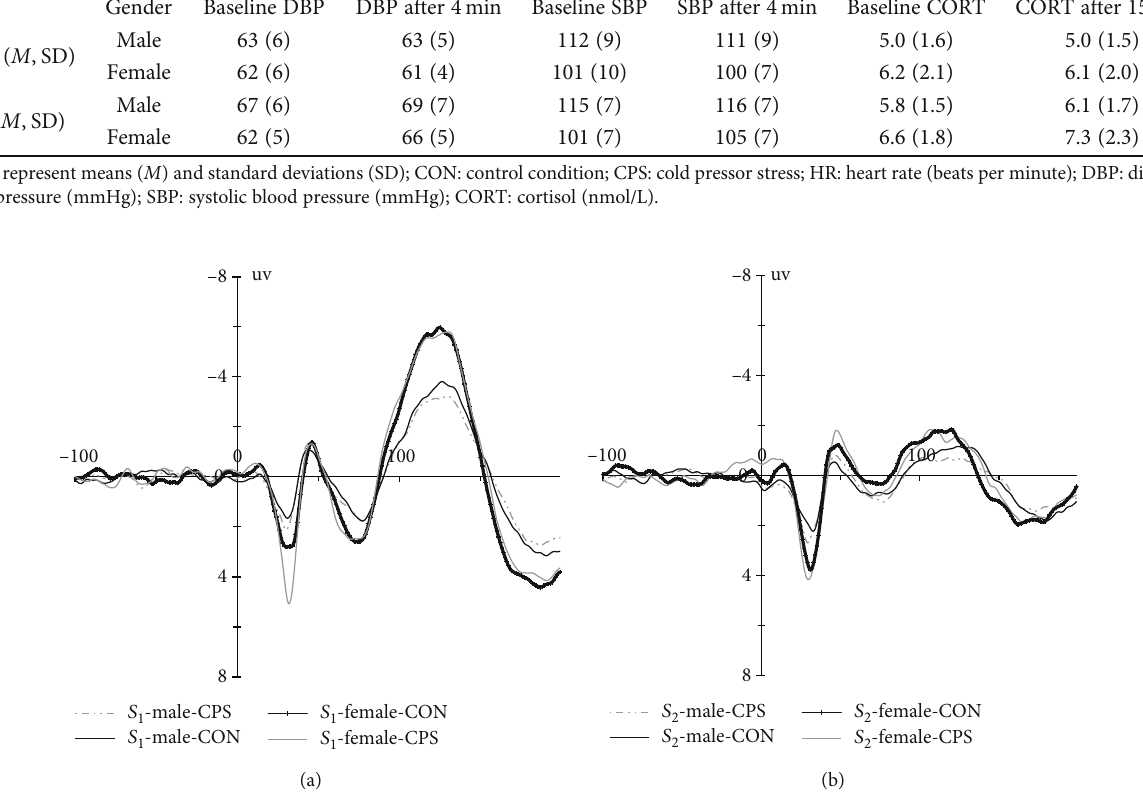
) elicited by paired clicks ((a) S z